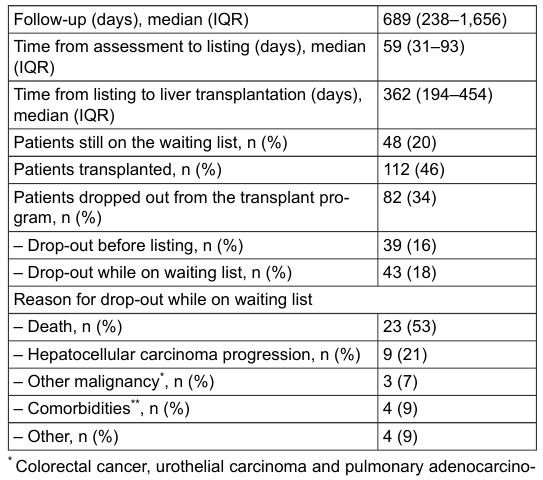
Table 2: Follow-up of patients after first assessment for liver transplantation (n = 242).